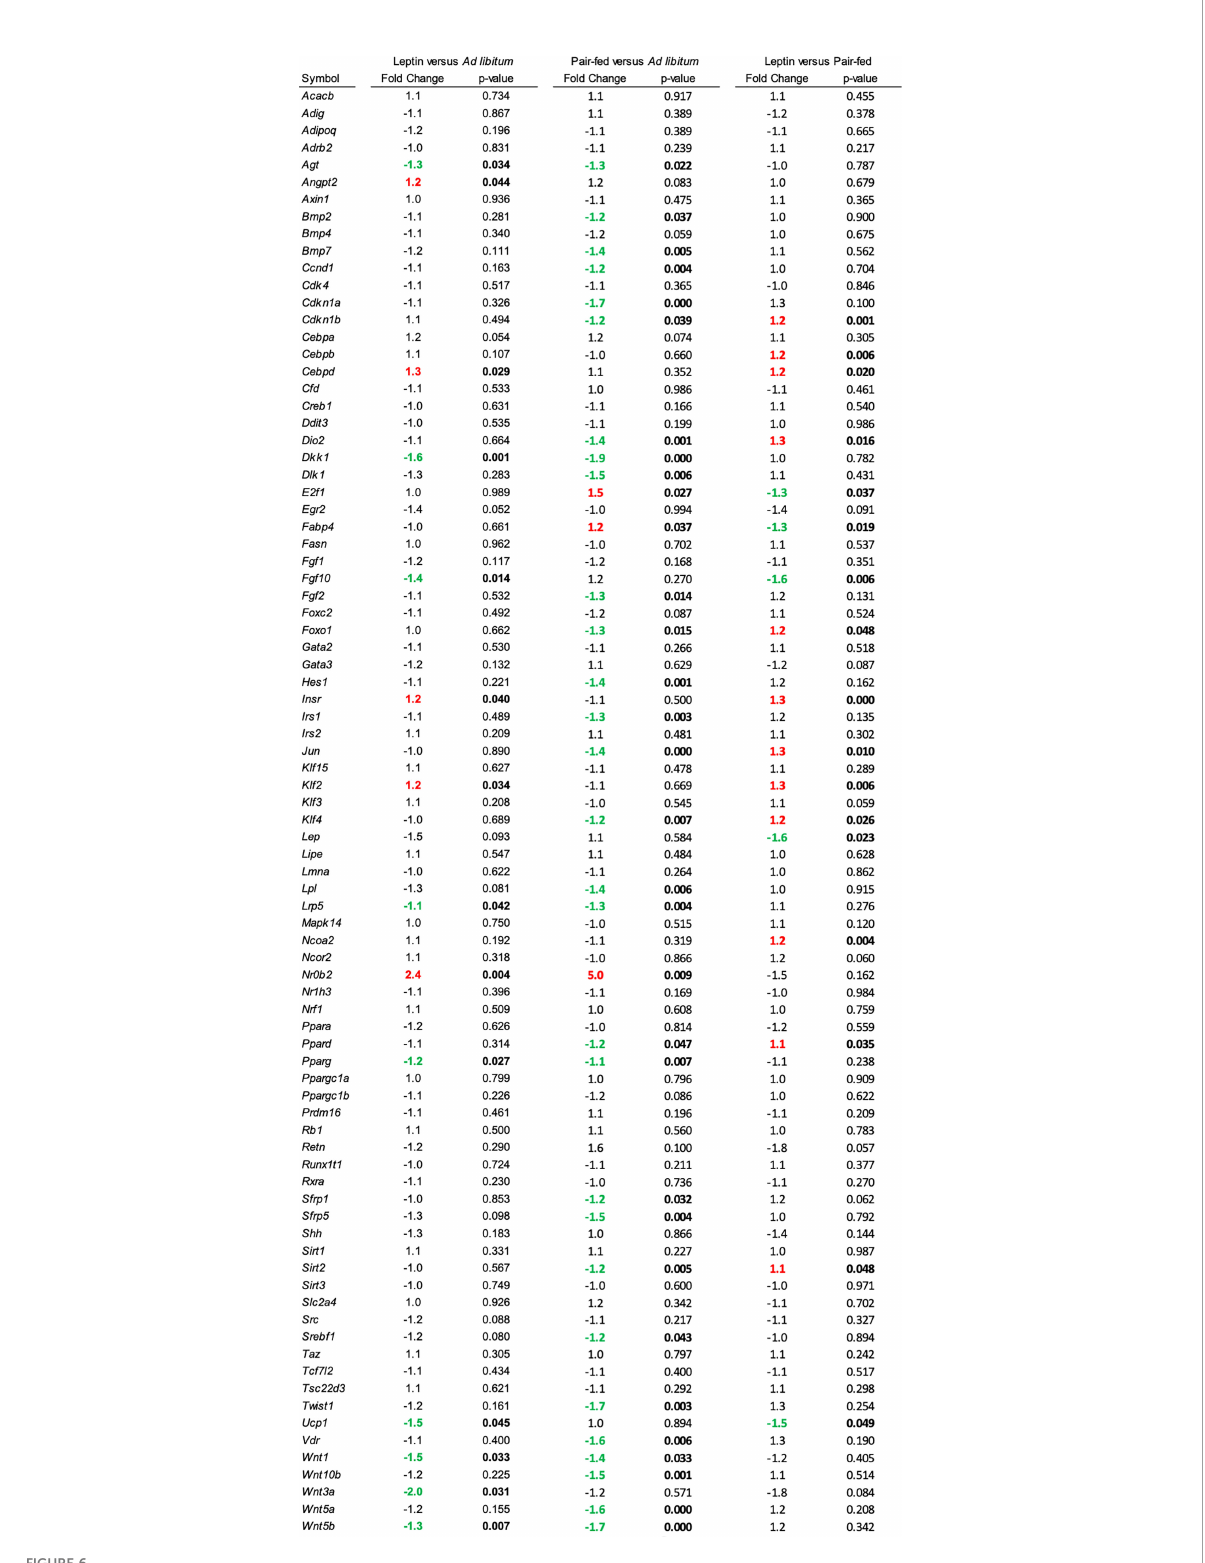
FIGURE 6 Differentially expressed genes in tibia in (1) leptin-supplemented versus ad libitum control mice, (2) pair-fed versus ad libitum control mice, and (3) leptin-supplemented versus pair-fed